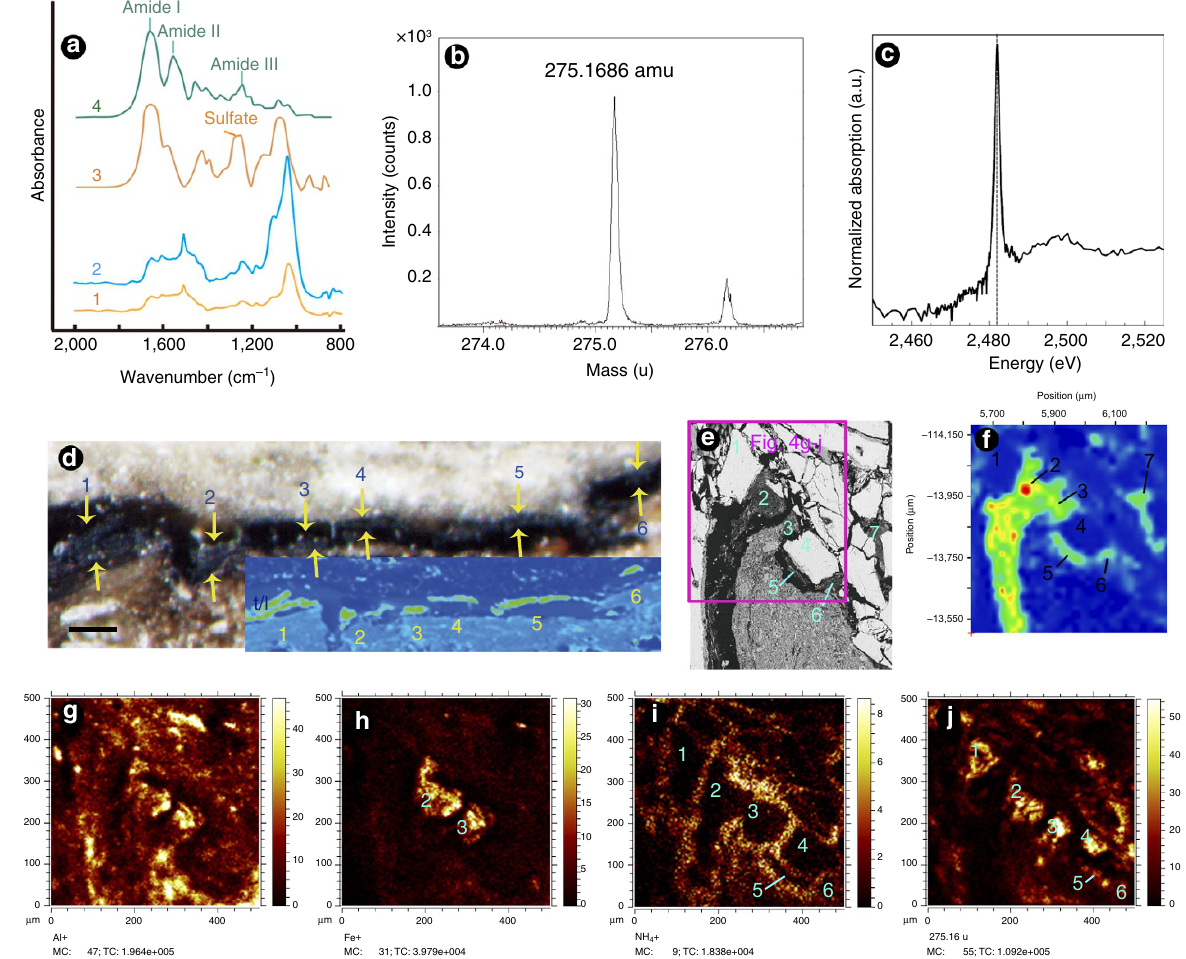
Figure 4 | Chemical analyses of the putative soft tissues in the Confuciusornis hindlimb. ( a ) Comparison of FTIR spectra (1–2) obtained from two spots on the supposed soft tissues with the typical proteoglycan aggrecan (3) and collagen (4) 26 . ( b ) Mass spectra of detailed region in 274–276.5 AMU of the supposed soft tissues. ( c ) Sulfur K-edge XANES spectrum from the high-sulfur region showing that the dominant sulfur species is sulfate (edge position for sulfate standard at 2,482eV indicated by vertical dashed line). ( d ) False colour synchrotron microfocus XRF map of sulfur in the rectangular area in Fig. 1g shows that the high-sulfur regions (yellow-green colour, inset:#1–6) are correlated with the distribution of tendons/ligaments (#1–6). Scale bar, 100 m m. ( e – j ) Comparison of the distribution of the inferred fibrocartilages (#2–3, 5–7) and possibly mineralized fibrocartilages (#1, 4) in BSE-SEM image of the rectangular area in Fig. 3b ( e ) and FTIR map of the strong absorbance region of 1,400–1,700cm (cid:2) 1 in the same area ( f ) and ion images of the spatial signal intensity distribution in the square area in Fig. 4e for Al þ ( g ), Fe þ ( h ), NH 4 þ ( i ) and the peaks at 275.16 AMU ( j ) in negative ToF–SIMS spectra. The FTIR map was collected using a Thermo IN10MX infrared microscope with a cooled MCT